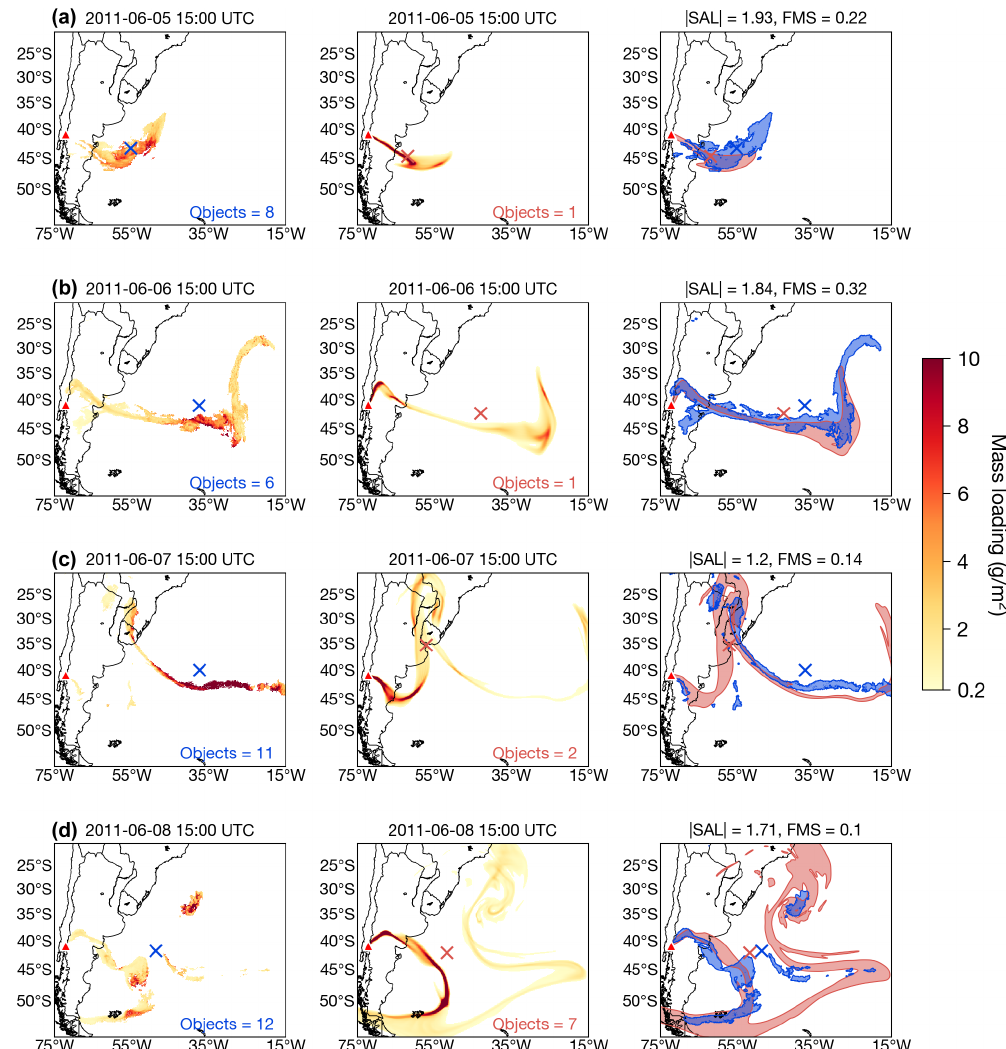
Figure 2. Same as Fig. 1 but without data